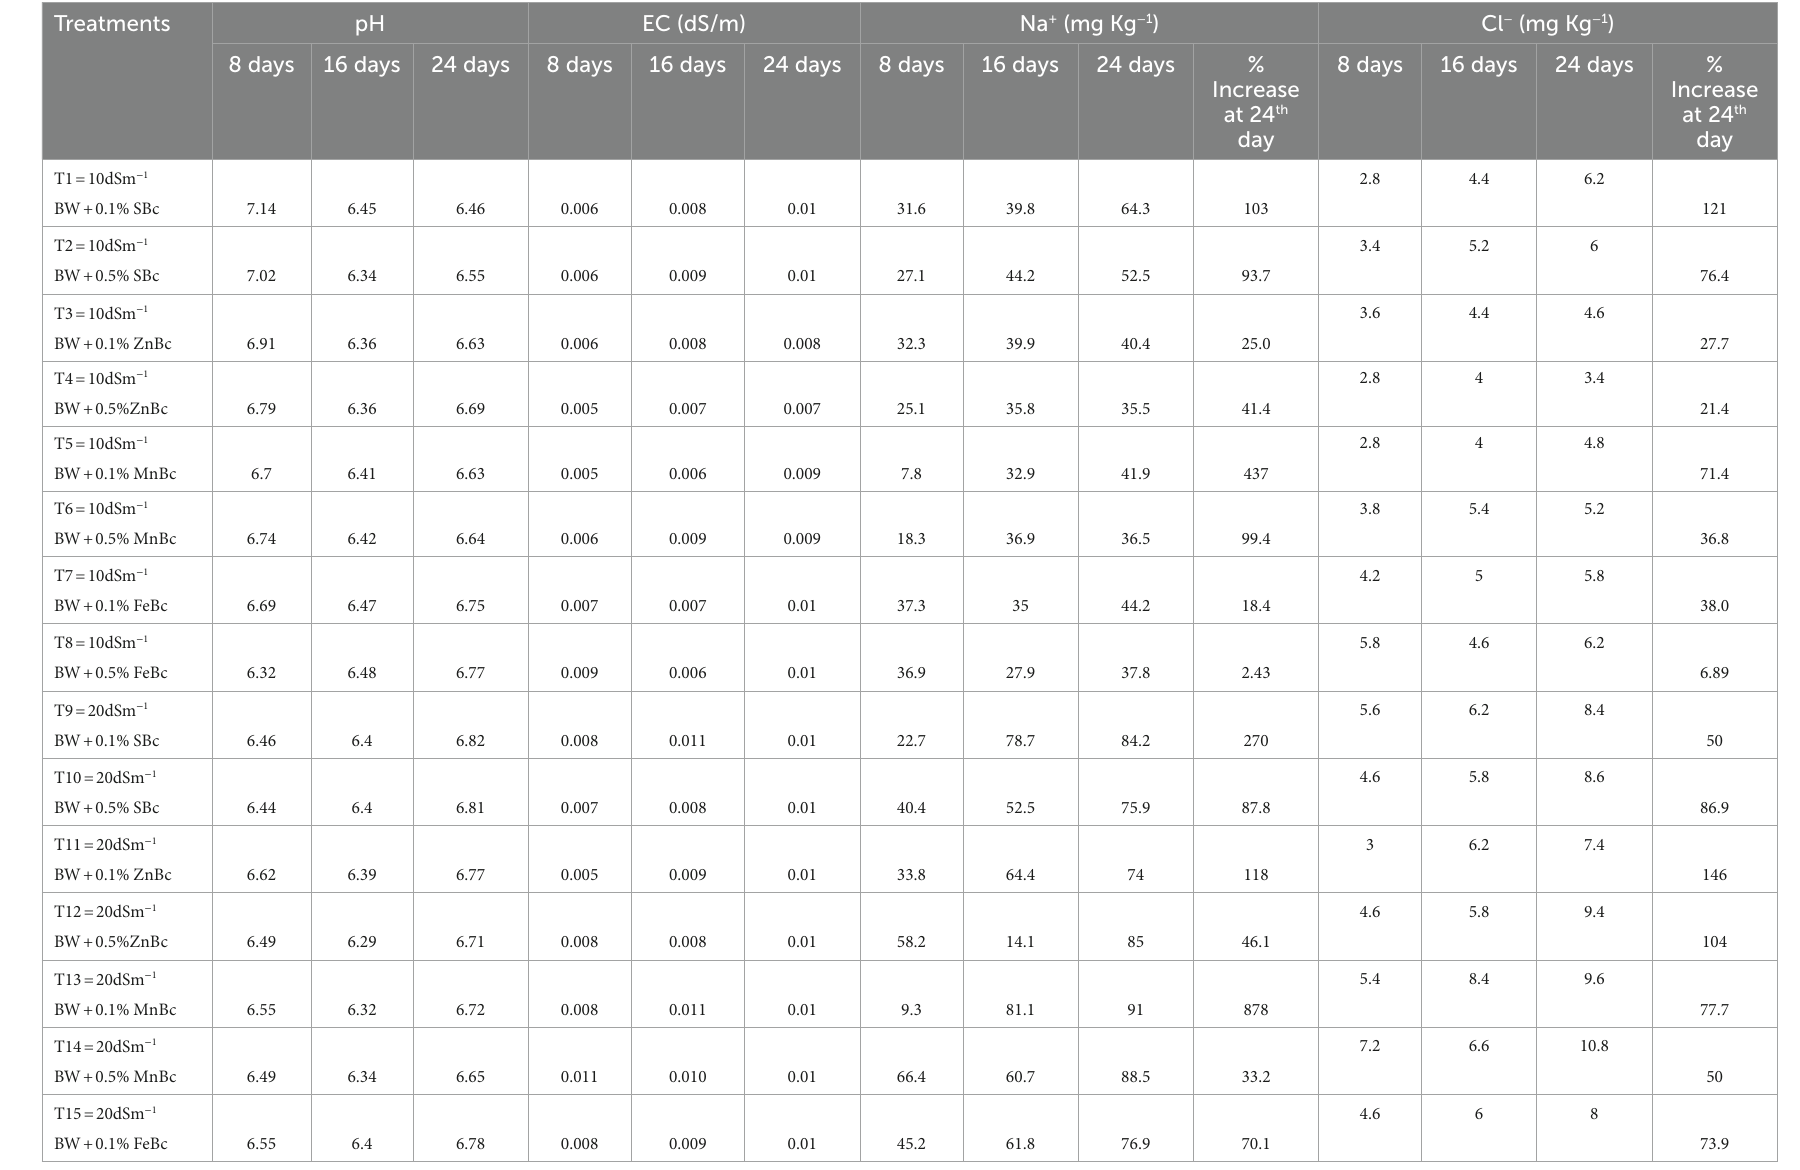
TABLE 2 A change in soil pH, electrical conductivity (EC), Na + , and Cl − concentrations studied at different time intervals with various rates of brackish water (BW) and rice husk biochars such as simple biochar (SBc), zinc biochar (ZnBc), manganese biochar (MnBc), and iron biochar (FeBc) under an incubation trial.